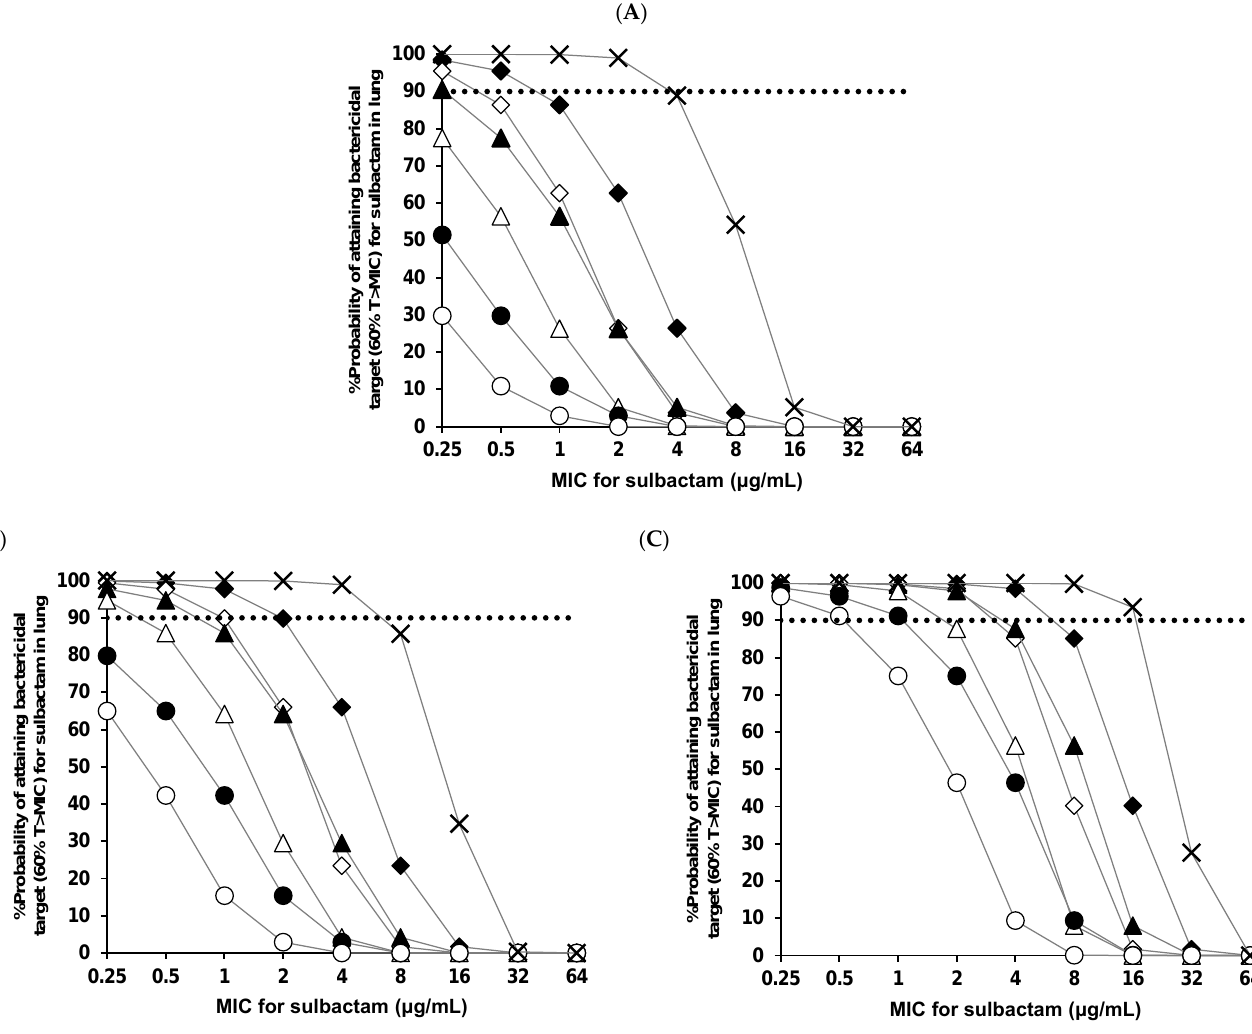
Figure 3. Probabilities of attaining bactericidal (60% T > MIC for sulbactam) targets in lung tissue at specific MICs for typical patients of ( A ) CL cr = 90 mL/min, ( B ) CL cr = 60 mL/min, and ( C ) CL cr = 30 mL/min, respectively. The lines represent the probability of target attainment for each dosing regimen of ampicillin/sulbactam ( 〇 3.0 g twice daily, 0.5-h infusion; ● 6.0 g twice daily, 0.5-h infusion; △ 3.0 g three times daily, 0.5-h infusion; ▲ 6.0 g three times daily, 0.5-h infusion; ◇ 3.0 g four times daily, 0.5-h infusion; ◆ 6.0 g four times daily, 0.5-h infusion; × 9.0 g three times daily, 4-h infusion). The dotted black line represents a 90% probability. MIC, minimum inhibitory concentra- tion.